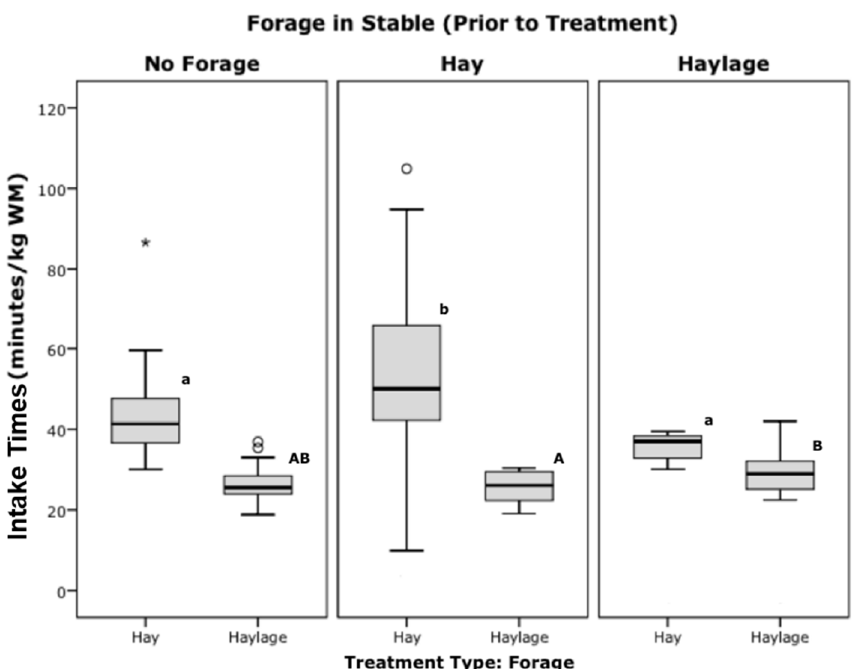
Figure 10. Intake times, grouped by forage in stable prior to treatment and forage treatment type (Significance between hay feeding tests are shown by lower case letters, and between haylage are shown by upper case letters, with those that do not share the same superscripts being significantly different, Anova, Bonferroni, p < 0.05; *, o = outliers).